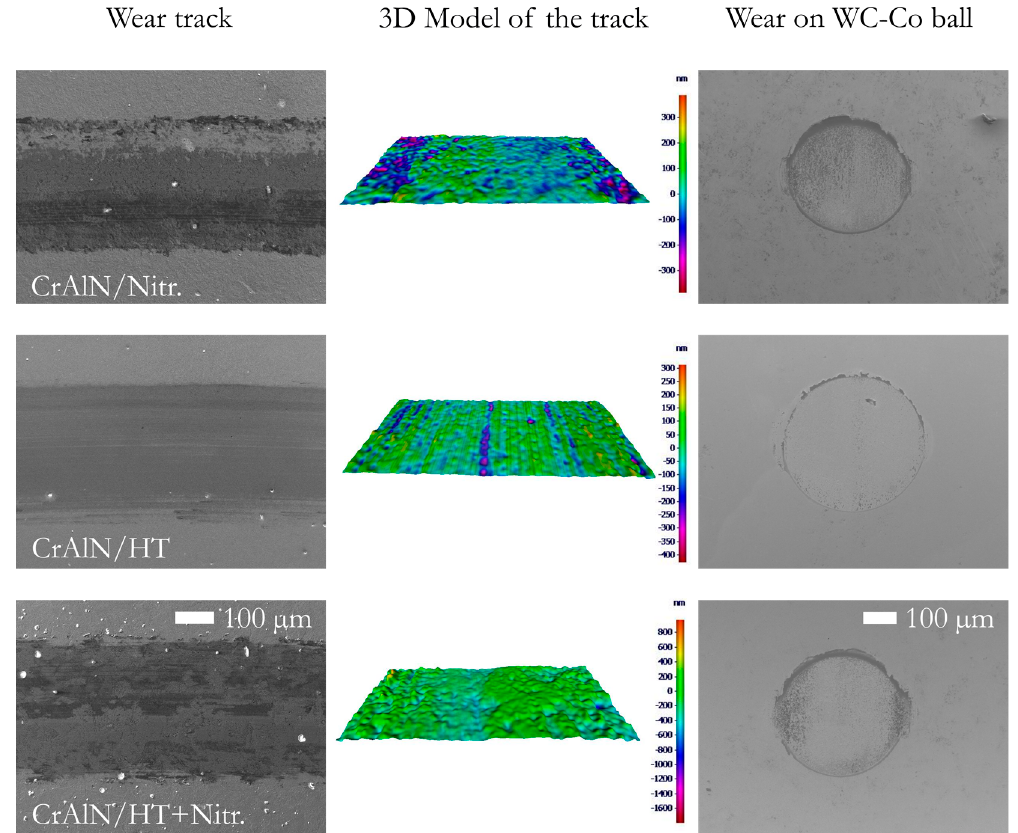
Figure 15. Wear tracks on the CrAlN coatings: SEM of the wear track (left), 3D Model (centre) and wear on the WC-Co ball (right).